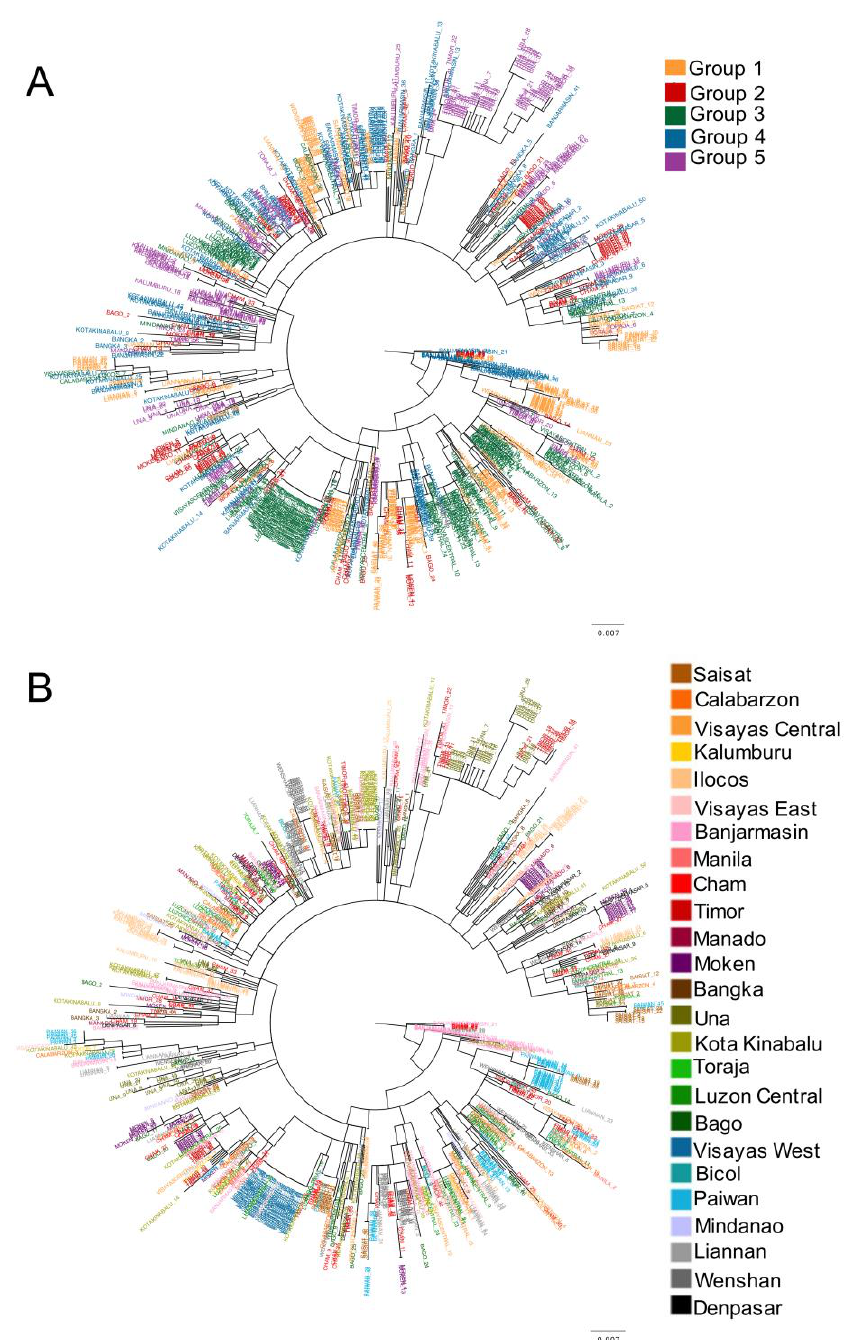
Figure 2. Phylogenetic tree reconstructed from the genetic data. Phylogenetic tree reconstructed with maximum likelihood, with sample names colored according to their corresponding geographic group ( A ) and studied population ( B ) (Figure 1 and Table S1).